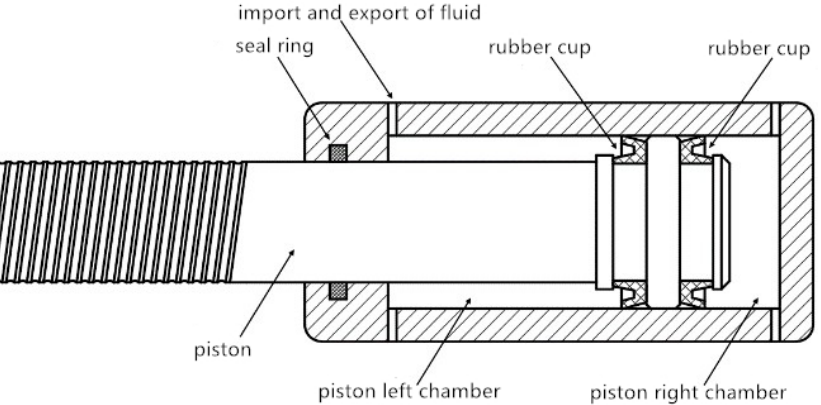
Figure 2. Structure of the power brake cylinder (excluding motor and transmission